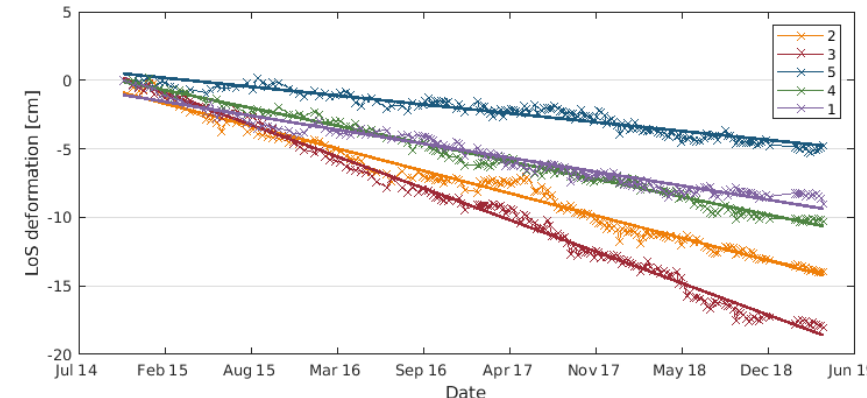
Figure 7. LOS deformation of some selected points (see Fig. 5 for location) determined from the ascending scenes.